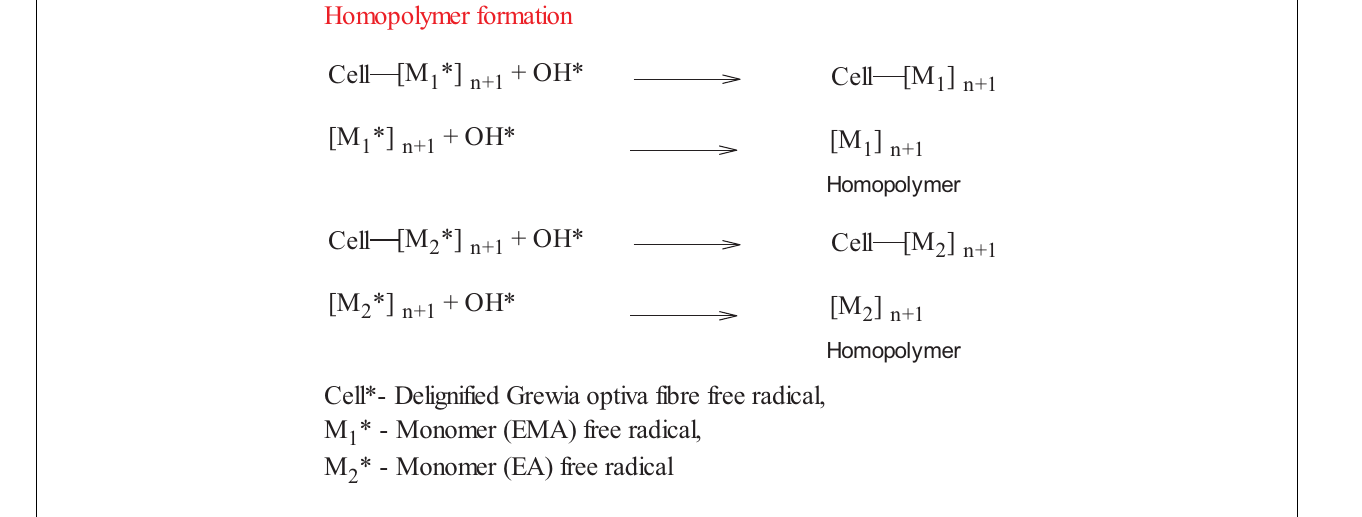
Scheme 1 | Probable mechanism of graft copolymerization of binary monomer mixture.